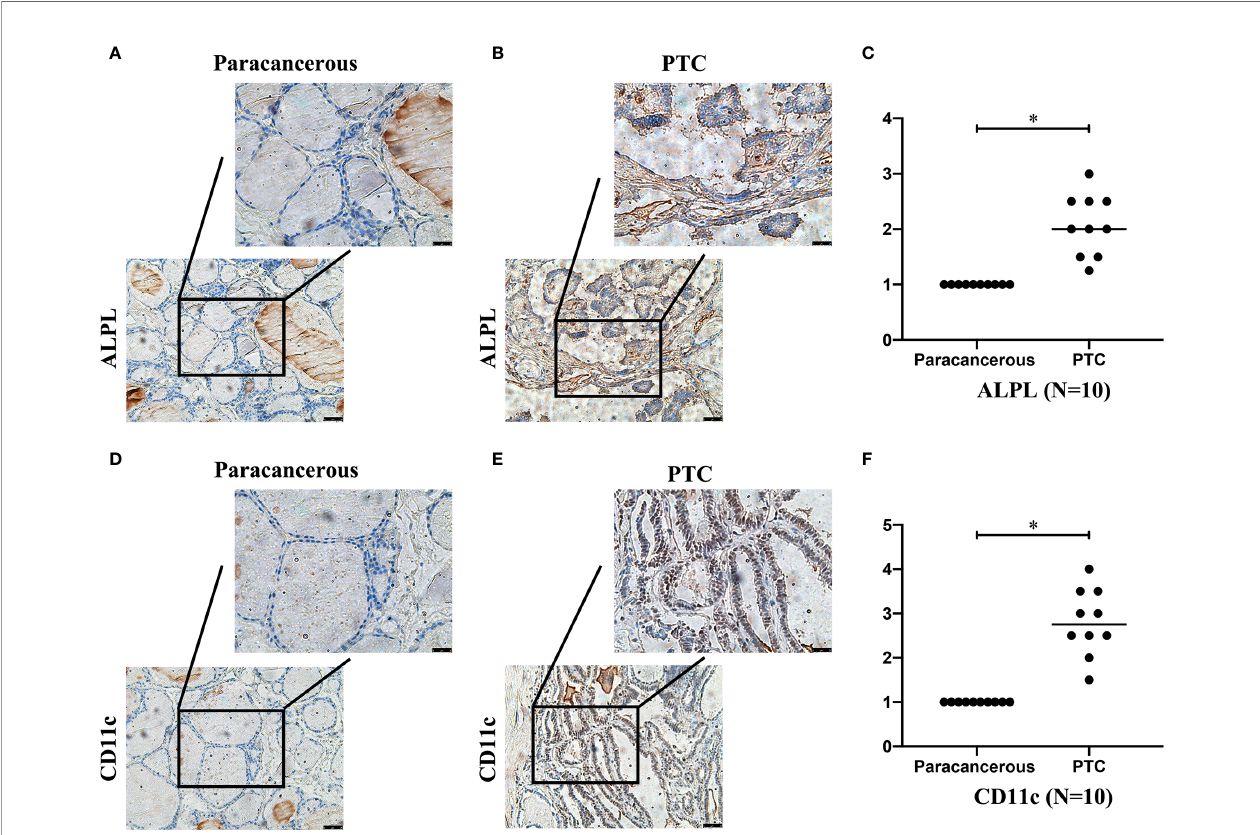
FIGURE 8 | The expressions of ALPL (A – C) and CD11c (D – F) proteins in papillary thyroid carcinoma (B, E) and paracancerous tissues (A, D) .